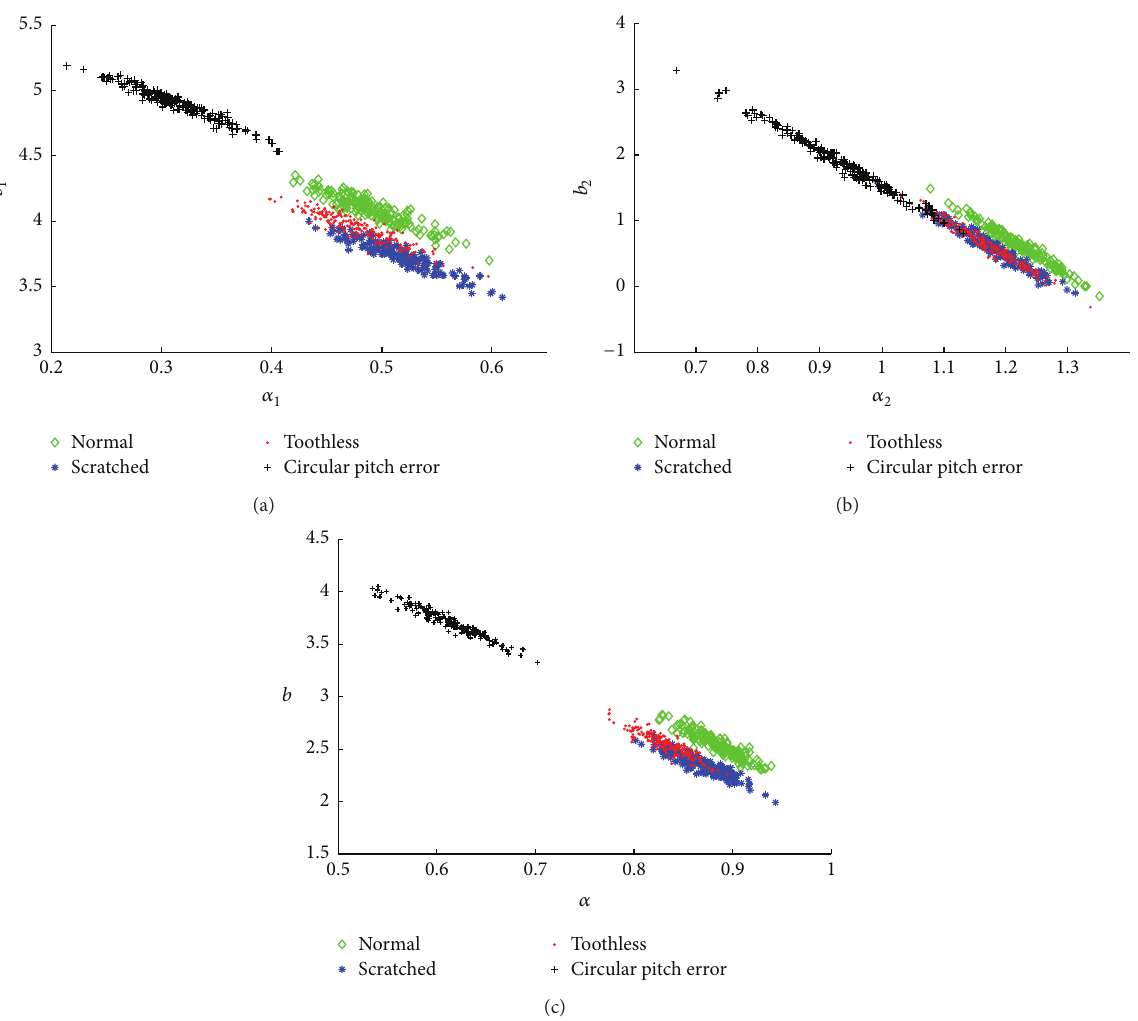
Figure 6: (𝛼, 𝑏) map of different ranges of scales: (a) 𝛼 1 and 𝑏 1 in the first range of scales; (b) 𝛼 2 and 𝑏 2 in the second range of scales; (c) 𝛼 and 𝑏 extracted by traditional DFA.